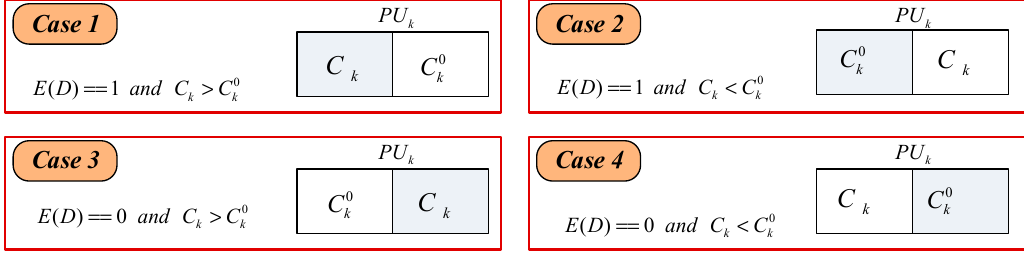
Figure 5. Four cases for padded unit (PU) construction.